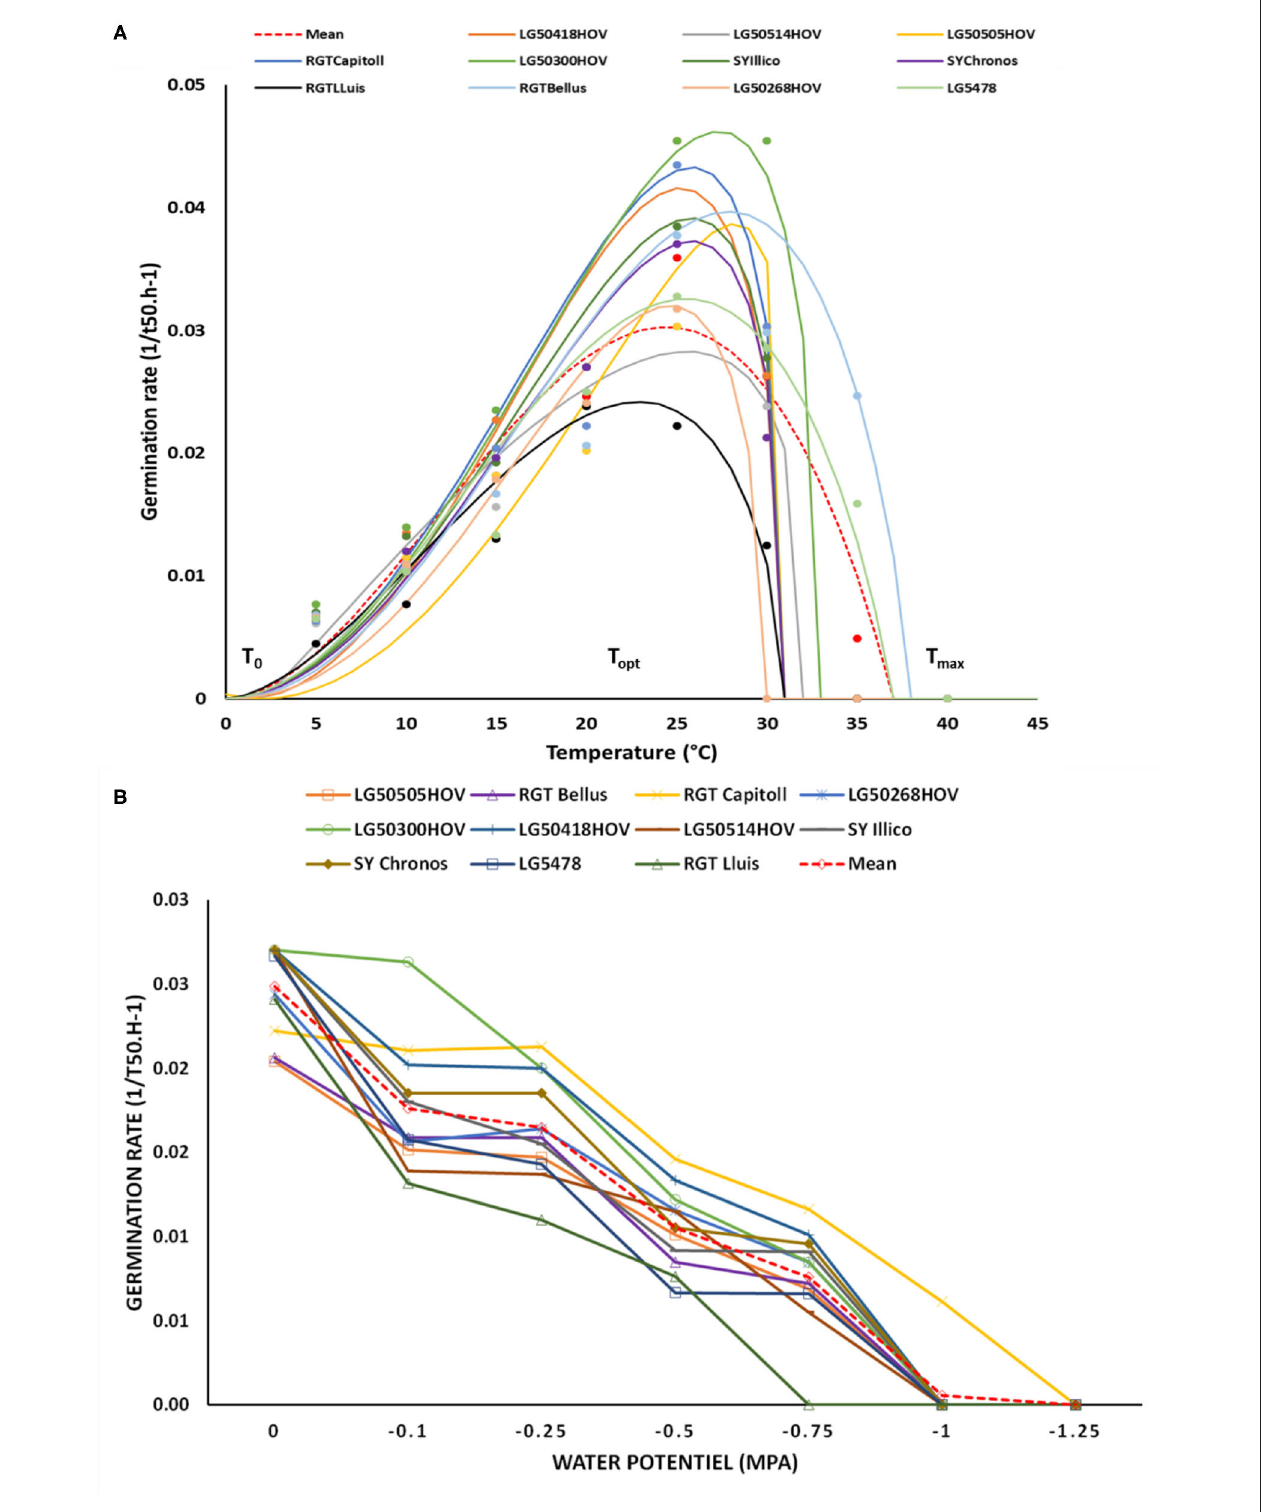
FIGURE 2 | Graphical representation of the Yin adjustments at 50% of germination (A) , and seed germination speed at different water potentials (B) of 11 hybrid oilseed sunflower varieties under laboratory conditions in 2020. The points in the first figure represent the mean observed data, the solid lines indicate the adjusted Yin function while T 0 , T opt , T max indicate cardinal temperatures (refer to Table 3 for detailed information).